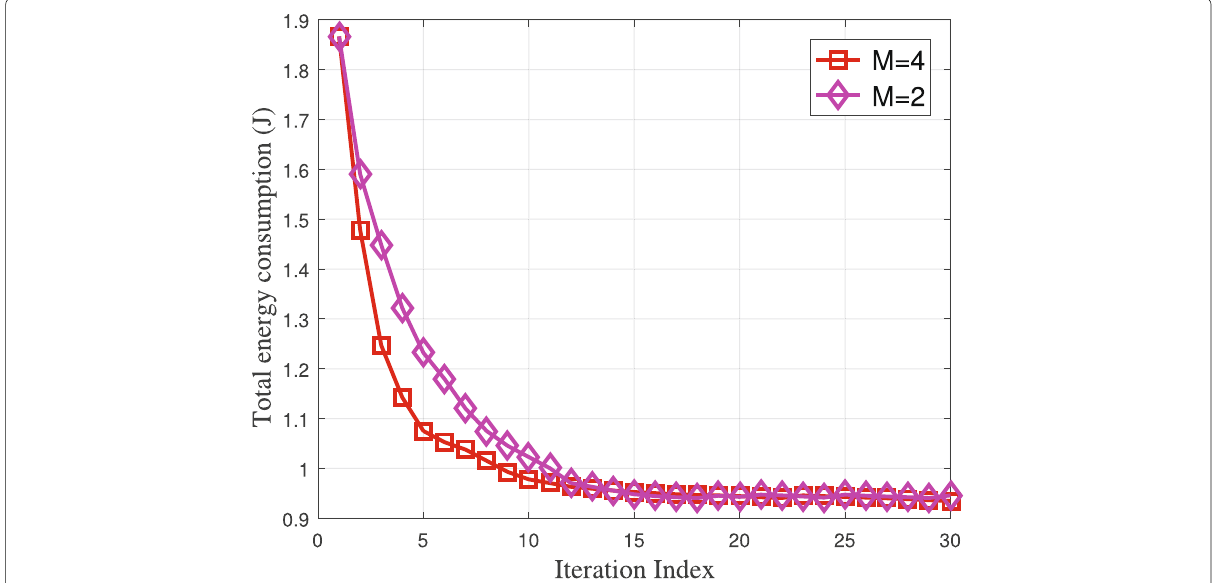
Fig. 3 Total energy consumption versus